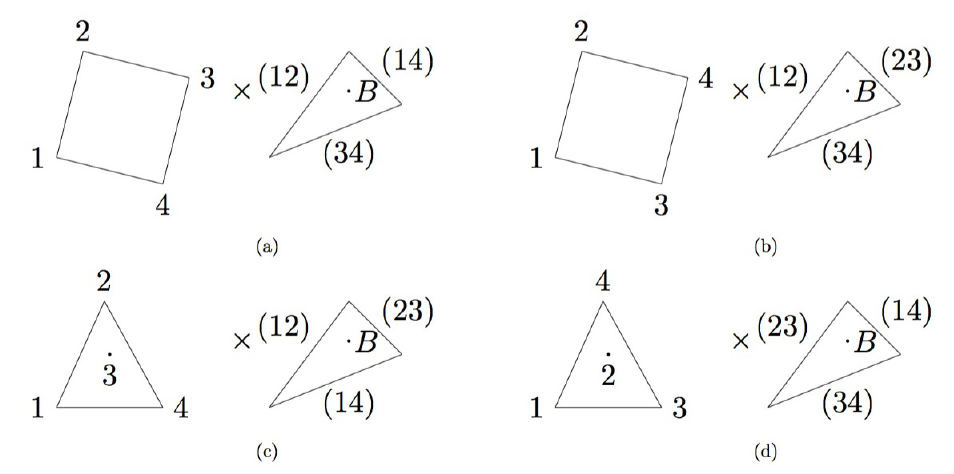
Figure 8 . Four point con(cid:12)gurations written as (con(cid:12)guration in A ) and (allowed region in B